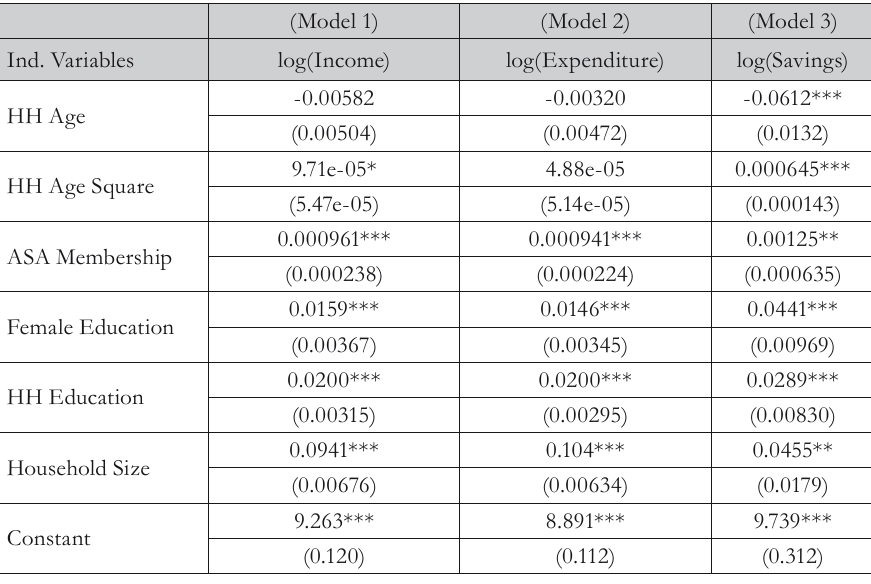
Tab. 1 – Results of the Regression Models on the Financial Indicators. Source: Authors own